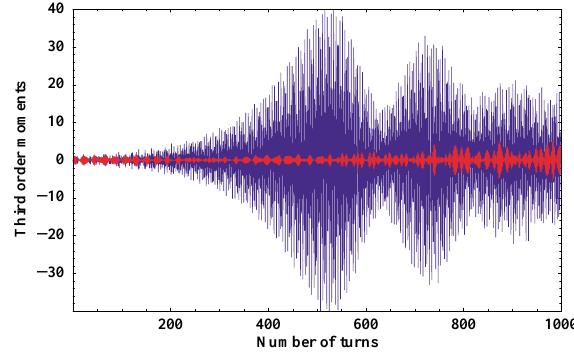
FIG. 7. (Color) Y - P y phase-space plot at 500 turns for (cid:2) (cid:1) (cid:1) 5.82, 5.79 (cid:2) . (cid:1) n x , n y